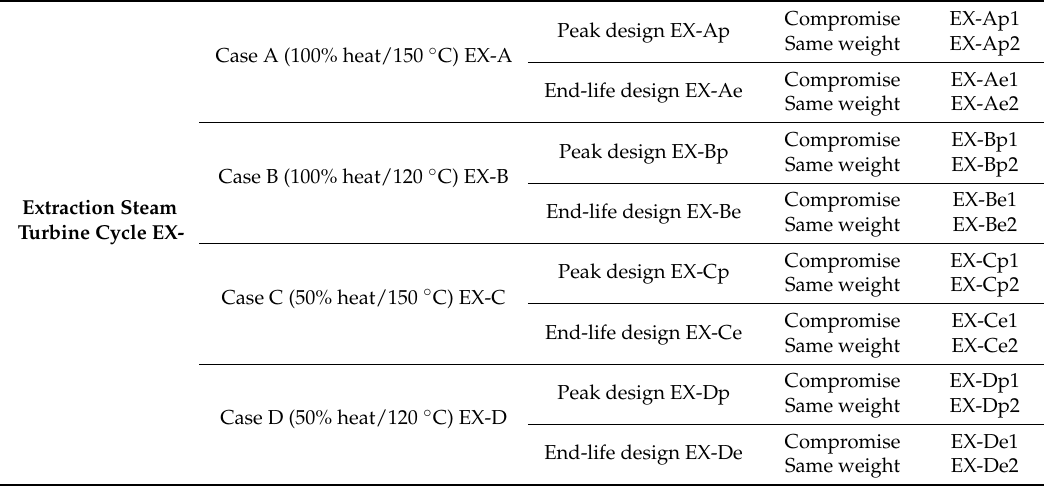
Table 6. Overview of all the designs defined for the extraction steam turbine cycle.